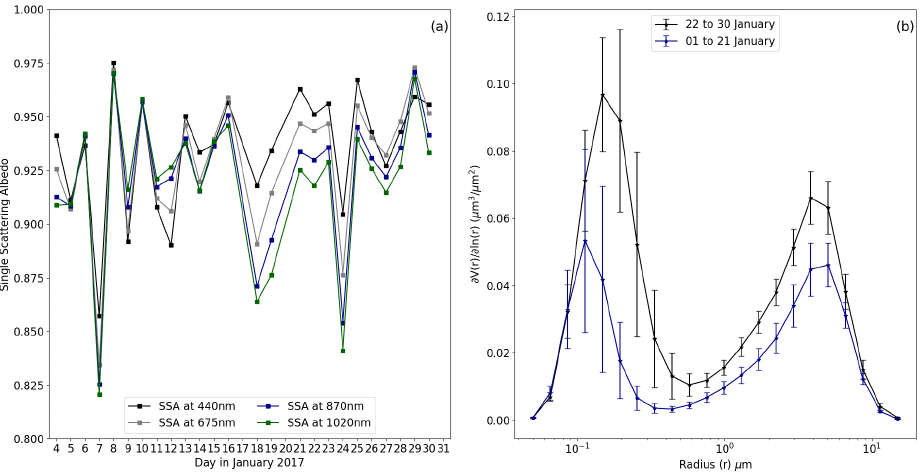
Figure A1. ( a ) CO emissions diurnal (gray line) and vertical (black line) profile on 29 January at the grid point of maximum intensity. ( b ) Molecular ratio of fire-emitted species at emission for the same grid point. Percentages give the number of molecules of each species over the total number of all molecules emitted by the fires.